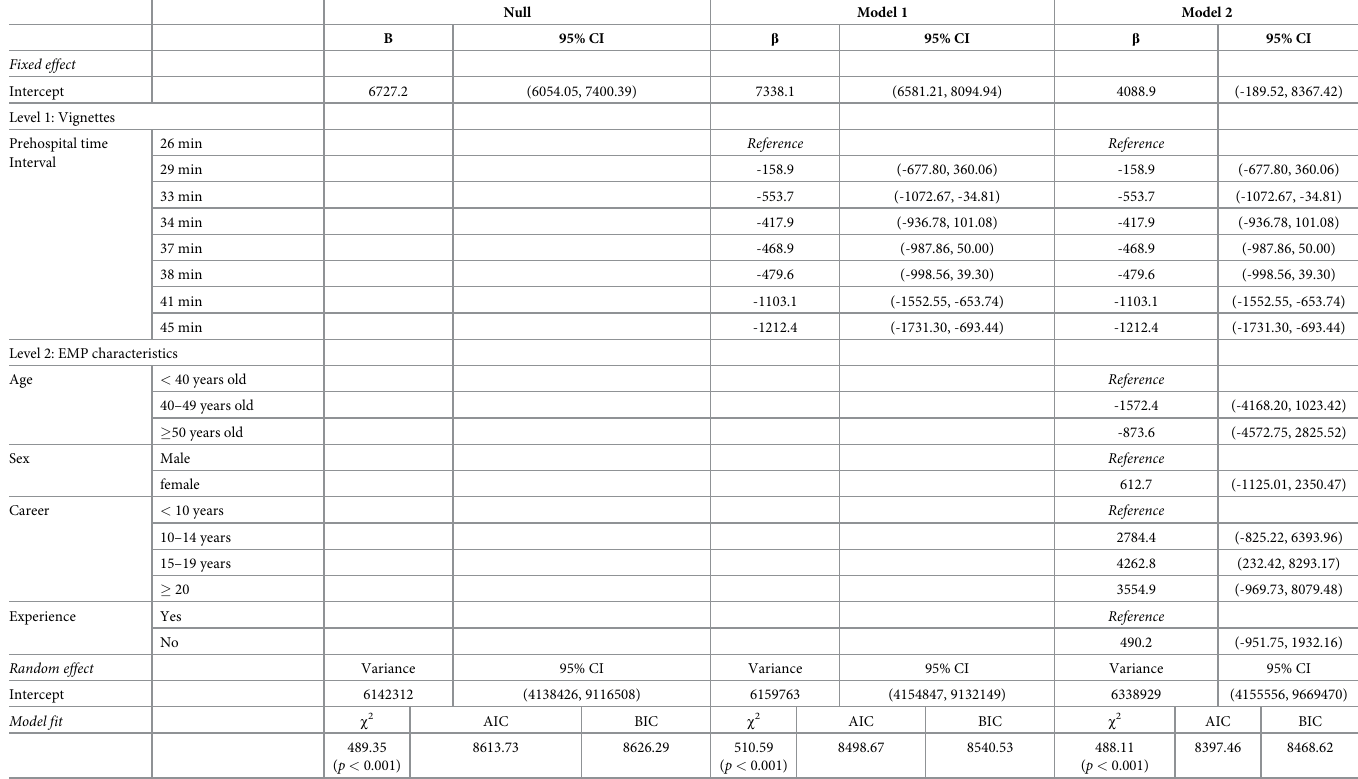
Table 5. Effect of prehospital time and EP characteristics on the willingness score for